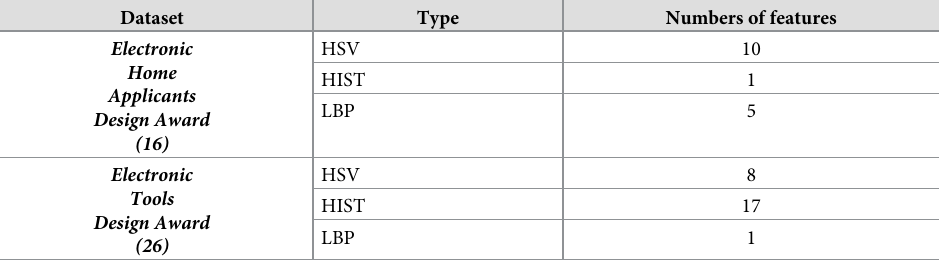
Table 7. Best features selection by CfsSubsetEvaluation via BestFirst